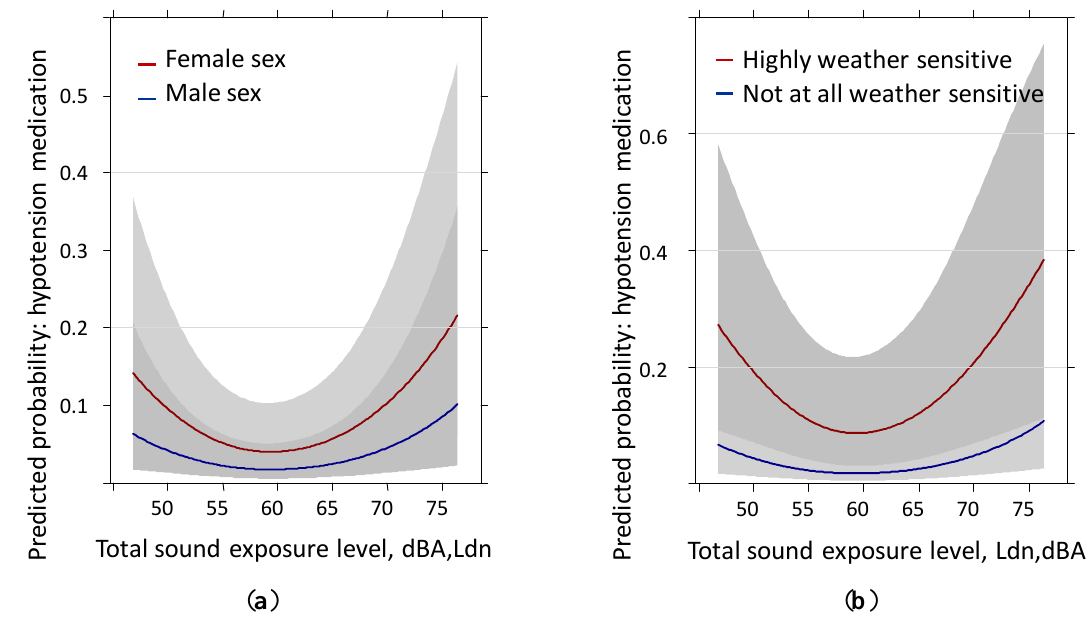
Figure 4. Predicted probability of hypotension medication past year with total sound level exposure by: ( a ) sex and ( b ) weather sensitivity. Models are adjusted for age, education, BMI, anti-hypertensive treatment, family history of hypertension, health status, sleep score, distance to main road, annoyance by local roads, region and the IA-term age ×